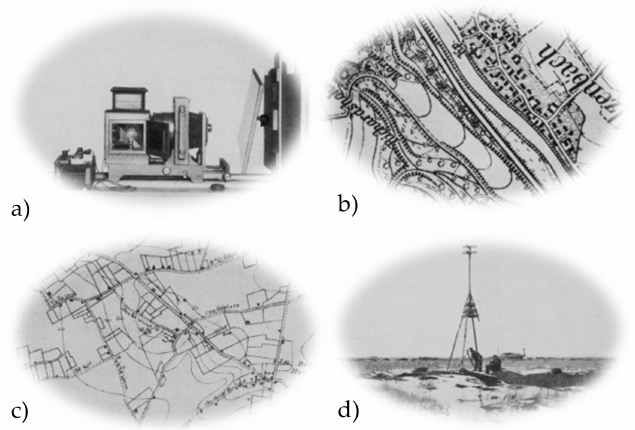
Figure 3. New-era techniques for mapping from aerial photographs. ( a ) Enlarging lantern and tilting copying board for the rectification of aerial photographs; ( b ) extraction of 1:25,000 maps from photos; ( c ) map for revision by plane-table and aerial photograph; ( d ) German triangulation signal (adapted